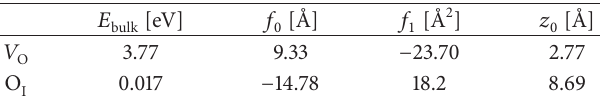
Table 3: Fitting parameters for defect formation energy as a func- tion of distance to the